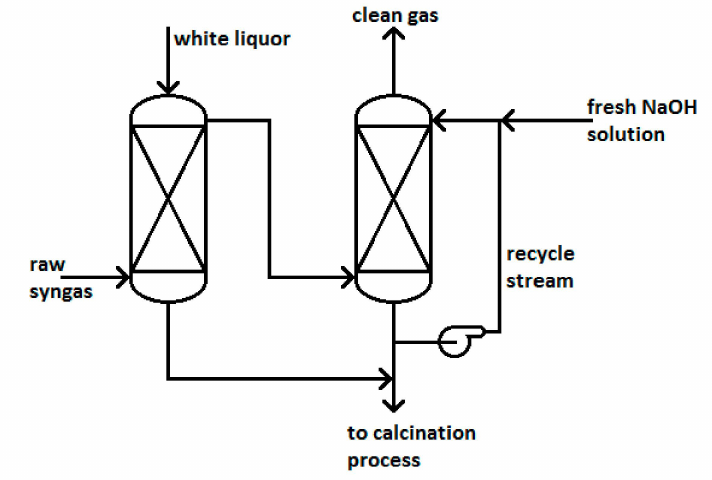
Figure 3. Scheme of syngas cleaning using white liquor and NaOH solution.